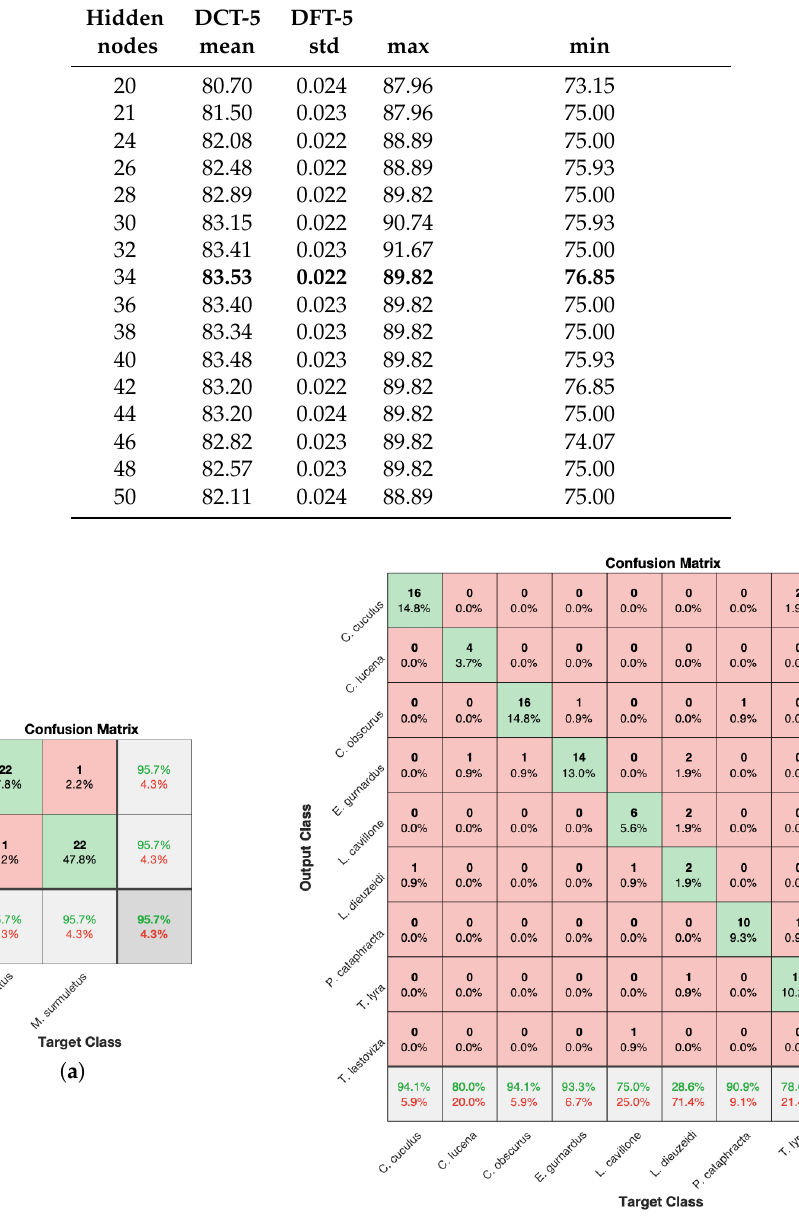
Table 3. The multi-class classification problem. Summary of the network accuracy obtained by using 10 features (five coming from the DCT and five from the DFT) depending on the hidden nodes used. The best results, highlighted in bold, are obtained when the net has 34 hidden nodes. The LOO-CV was performed and the experiments were repeated 1000 times.